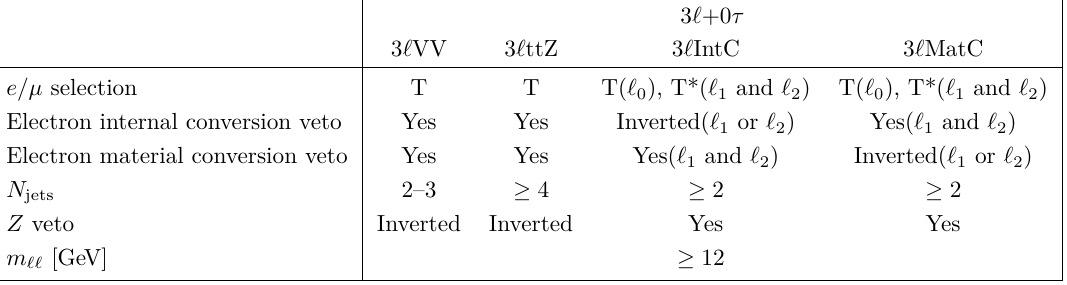
Table 7. Summary of four CR categories in the 3 ‘ +0 τ channel. All events are required to satisfy the preselection requirements. “T” and “T*” denote the Tight and Very Tight light-lepton selection criteria (see table 2). IntC and MatC stand for internal and material conversions,